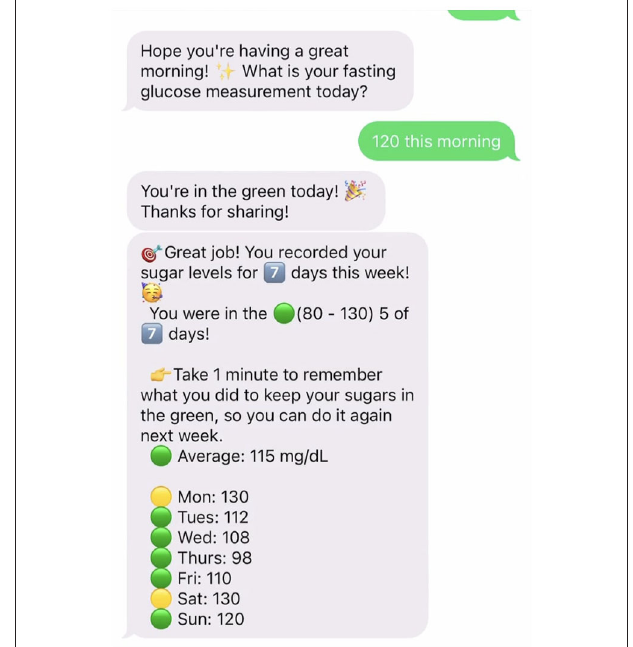
FIGURE 1 | Example of weekly SMS-based progress reports.